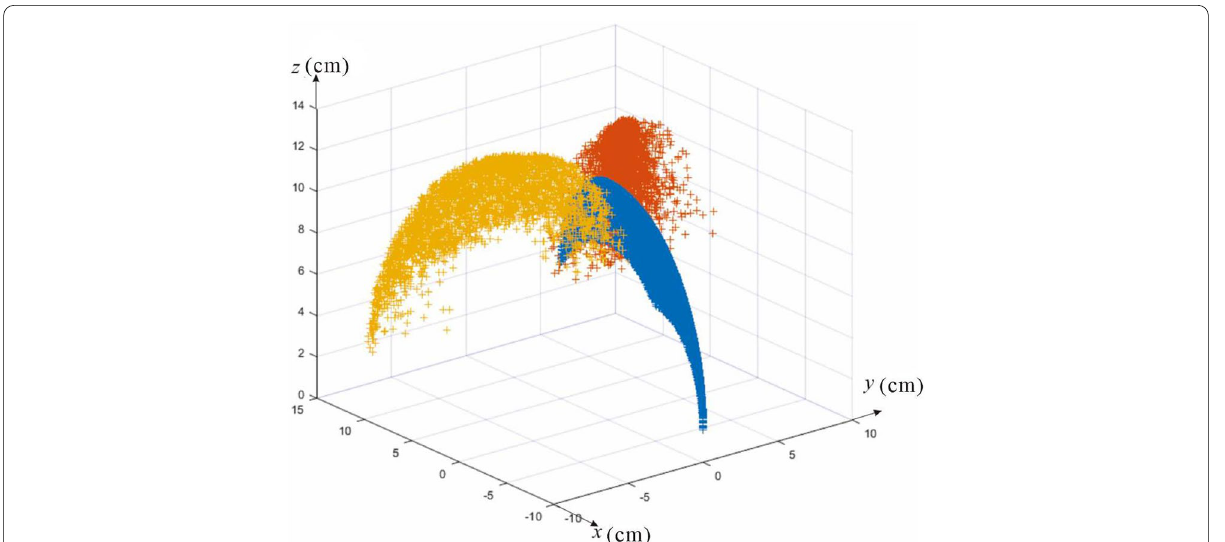
Figure 10 Finger workspace scatter plot of the metamorphic hand